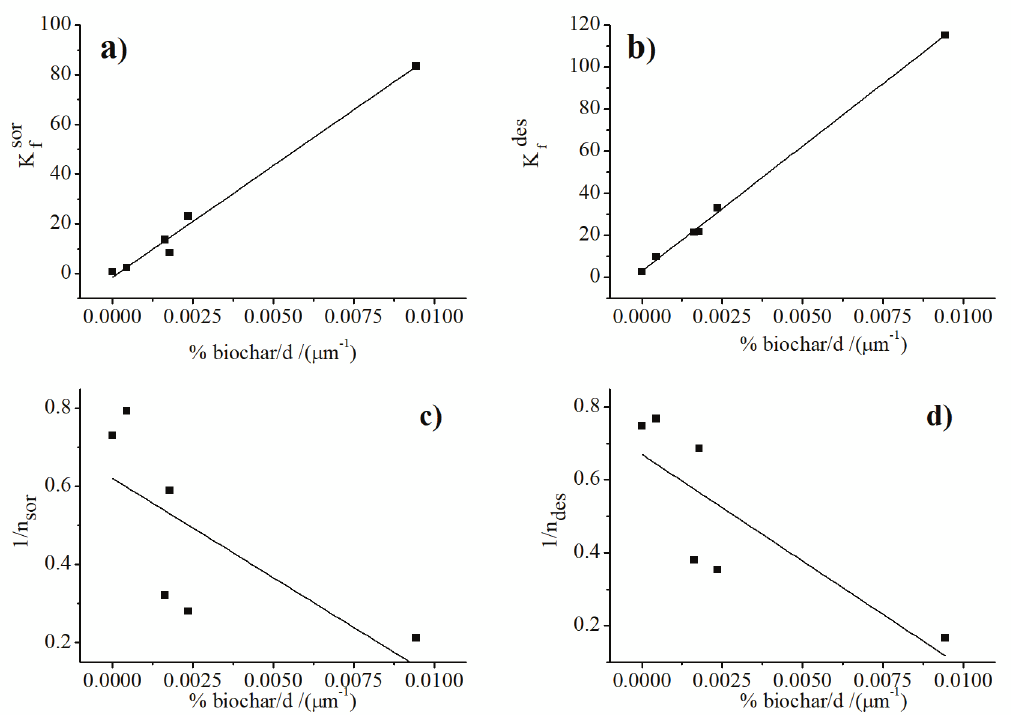
Figure 5 - Evaluation of the influence of the total external surface area of biochar on the sorption and dessorption of CMZ by the correlation of ratio % biochar/d with the parameters of the Freundlich equation ( a ) 1/n ( c ) and 1/n ( d ). sor des